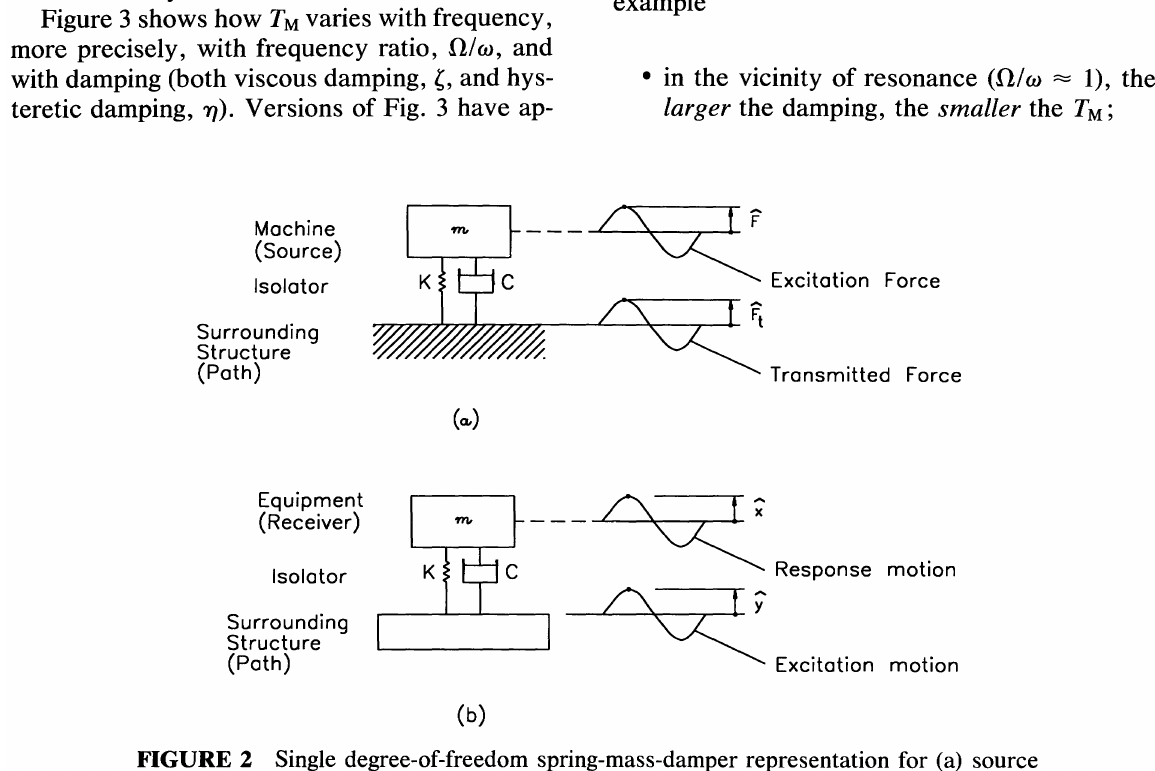
FIGURE 2 Single degree-of-freedom spring-mass-damper representation for (a) source isolation and (b) receiver